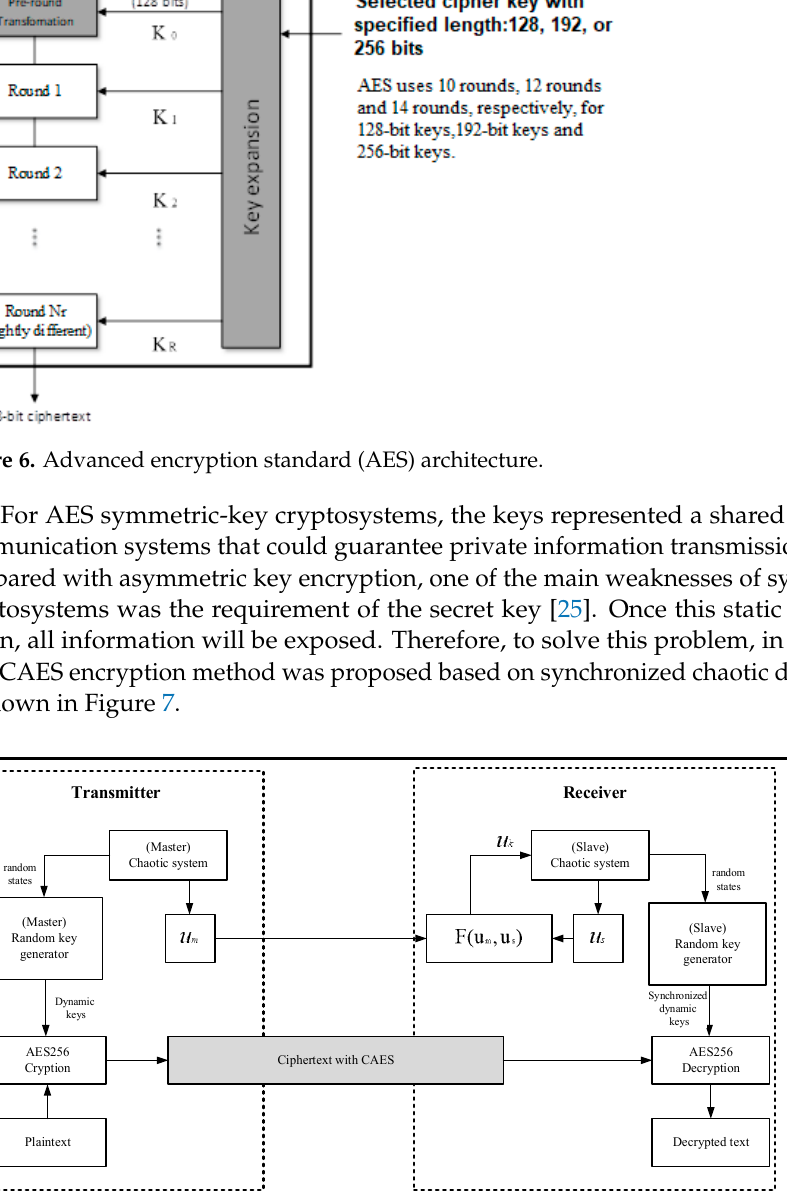
Figure 7. Improved chaos-based AES architecture.